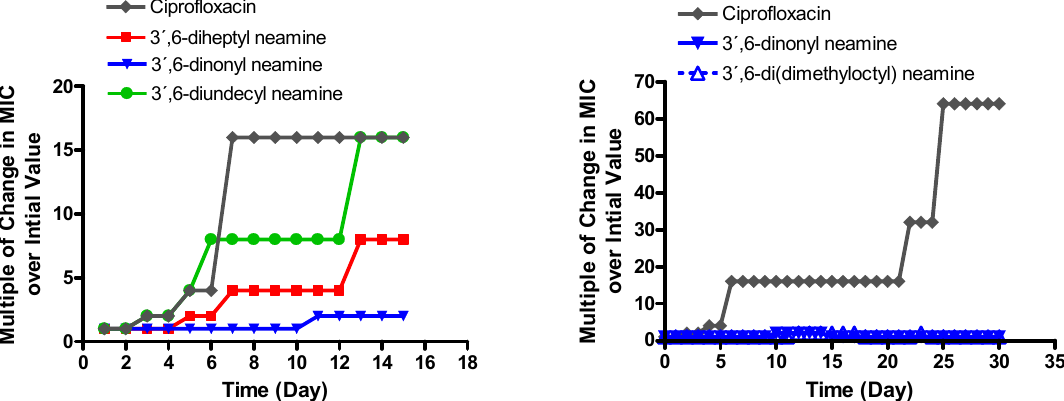
Figure 1. Evolution of the MIC against P. aeruginosa of ( left ) 3 ′ ,6-diheptyl neamine (C7), 3 ′ ,6-dinonyl neamine (C9), 3 ′ ,6- diundecyl (C11) neamine, ( right ) 3 ′ ,6-dinonyl neamine, and 3 ′ ,6-di(dimethyloctyl) neamine, in comparison to the evolution of the MIC of ciprofloxacin after exposure to half-MIC concentrations for the indicated times. The concentration of the antibiotic was readjusted each day to remain equivalent to half the MIC. Results are expressed in changes in MICs over initial value.